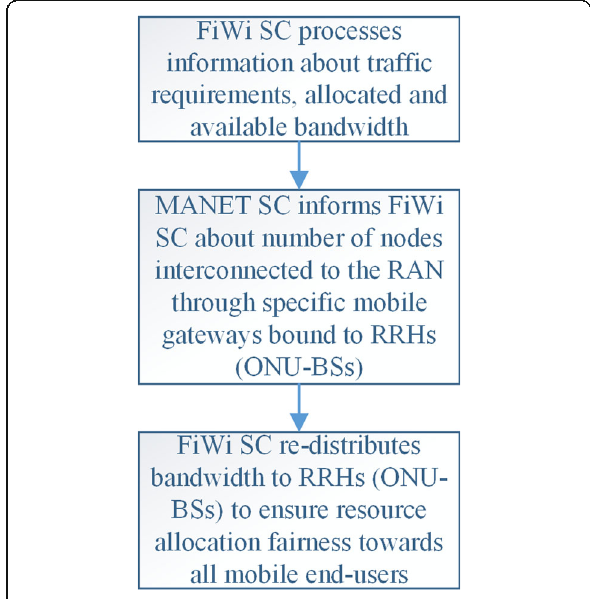
Fig. 10 Federated tasks performed by FiWi and MANET SDN controllers (SCs) to provide